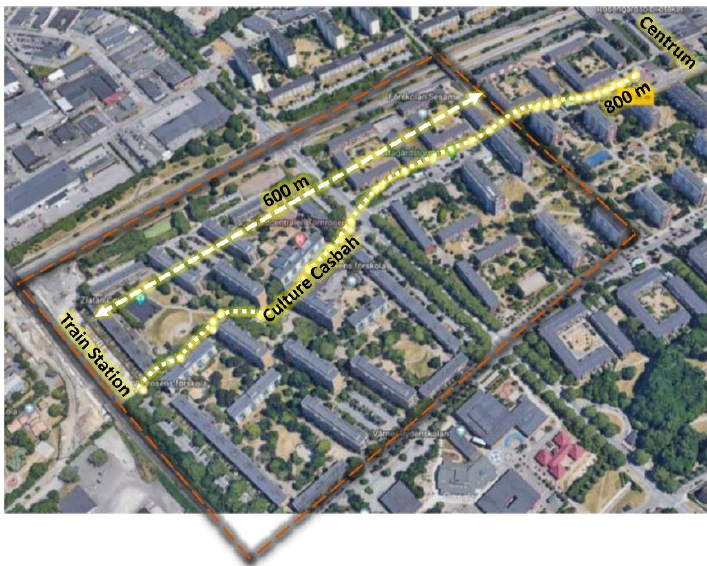
Figure 3. Map of Rosengård, Malmö (above), and the target area. Map illustrating the treated area. Source: created by the authors, May, 2019.